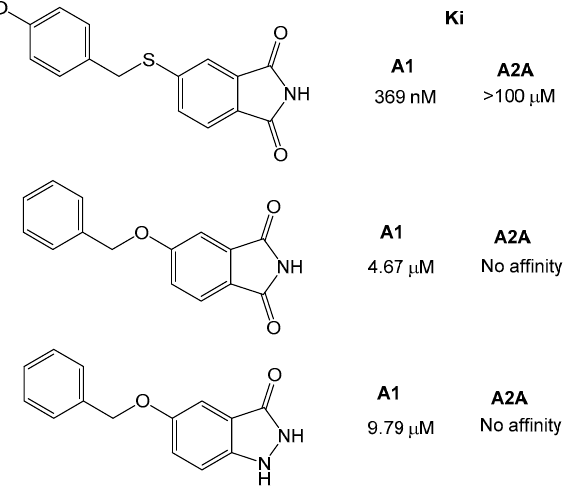
Figure 8. Structures of the phthalimide and istatin based compounds and their affinity for the adenosine receptors [32].